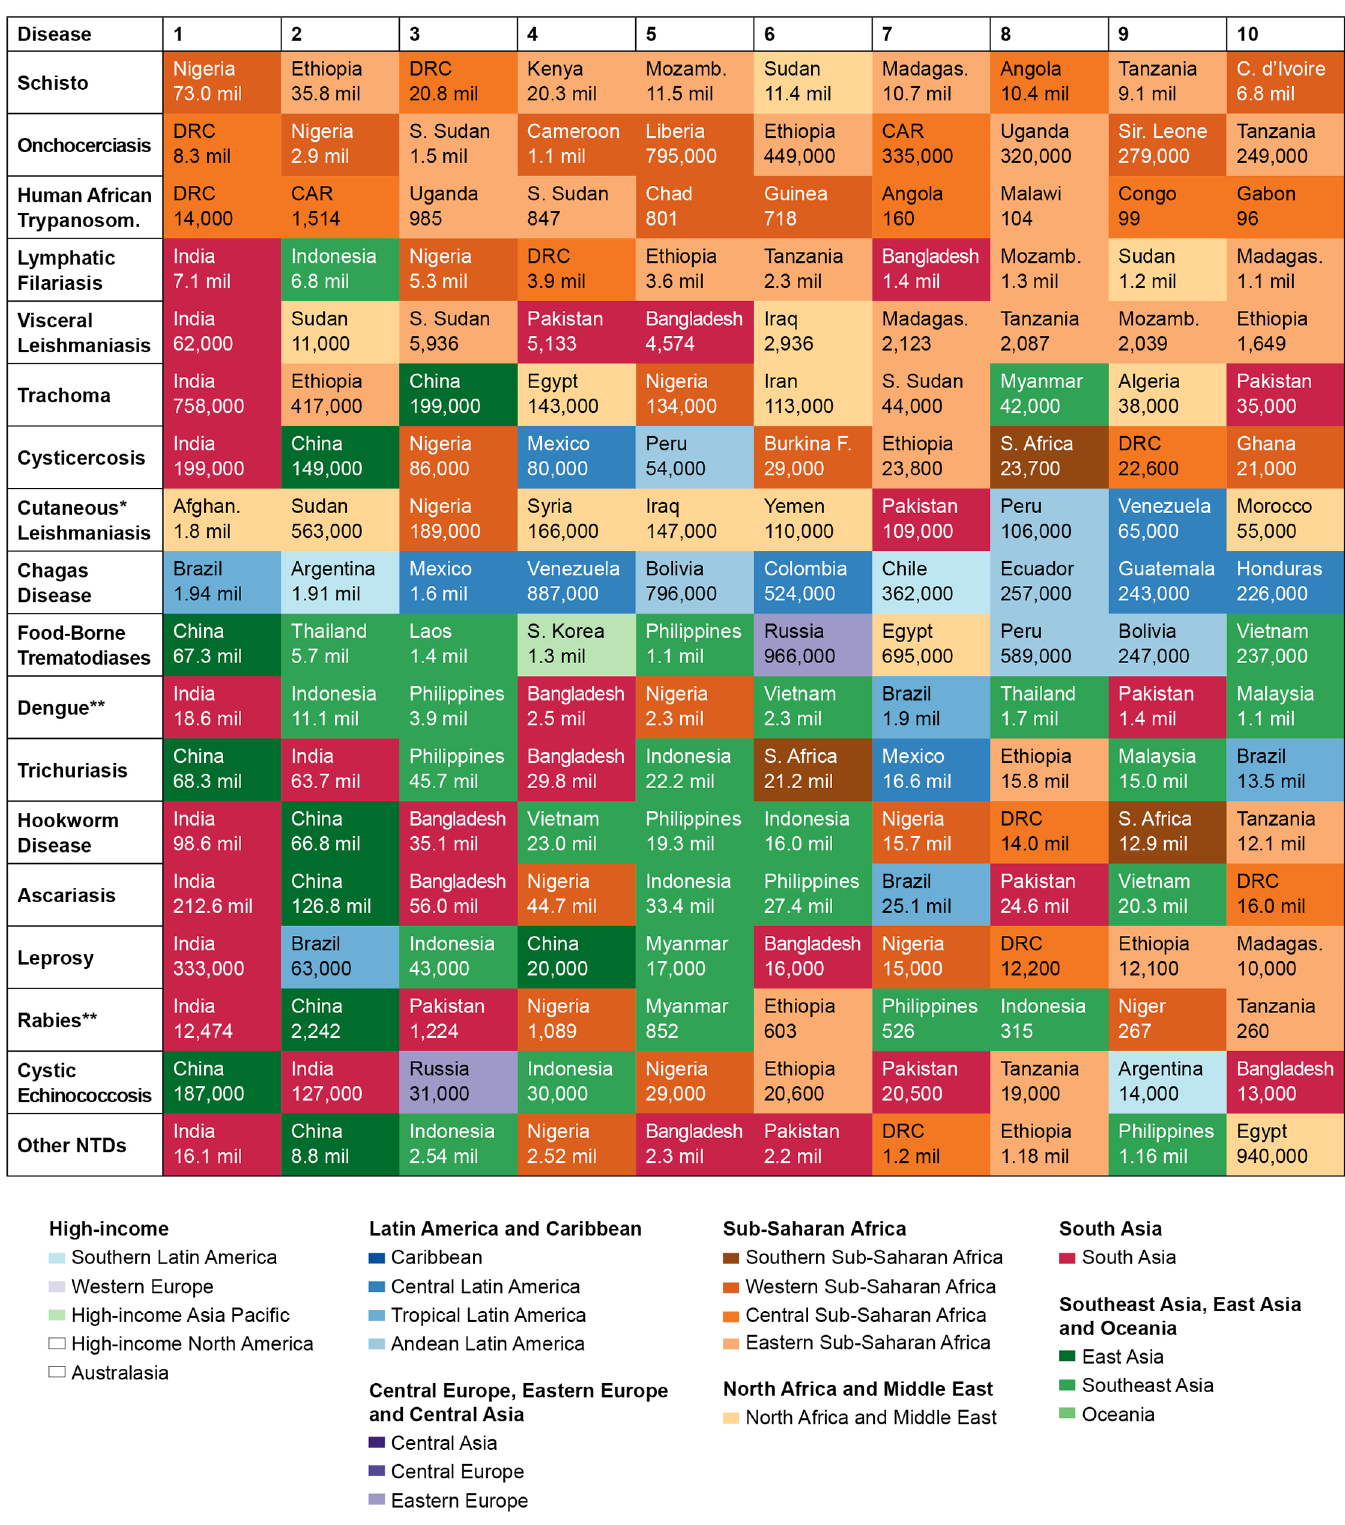
Fig 4. Countries with highest absolute number of NTD cases in 2013. Countrieswith the highestnumber of absolute cases for the diseasesindicated and the estimated numbersin each country. These data are also available from the Institute for Health Metrics and Evaluation (IHME) website. Countriesare color coded by Global Burden of DiseaseStudy (GBD) regions. Abbreviations: CAR, CentralAfrican Republic;DRC, DemocraticRepublicof the Congo; STP, S ã o Tome´ and Principe. * Also includesmucocutaneous leishmaniasis, ** Incidentcases rather than prevalentcases, NOTE: As in Table 1, only symptomatic cases are estimated for dengue,trachoma,cystic echinococcosis, cysticercosis, and rabies. https://doi.org/10.1371/journal.pntd.0005424.g004 PLOS NeglectedTropical Diseases | https://doi.org/10.1371/journal.pntd.0005424 August 3,